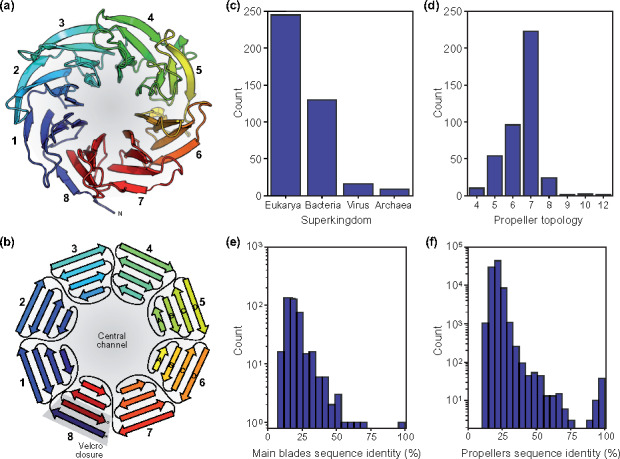
General features of the β-propeller fold and its representation in the Evolutionary Classification of Protein Domains (ECOD) database (Cheng et al., 2014) filtered to a maximum sequence identity of 70%, as of January 2020. (a) 3D structure of a β-propeller, exemplified by the crystallographic model of yeast ribosome assembly protein SQT1 (PDBID: 4ZOV_A), an 8-bladed member from the WD40 supercluster. (b) 2D fold topology of the fold depicted in (a), highlighting the different blades, the A-to-D naming of their constituent β-strands and the characteristic ‘velcro-closure’. (c) Taxonomic distribution, (d) number of blades distribution (topology), (e) median pairwise sequence identity between blades within the same β-propeller and (f) pairwise sequence identity between all β-propeller domains. For computing pairwise sequence identities, sequences were aligned with MUSCLE (Edgar, 2004) and only the aligned regions considered